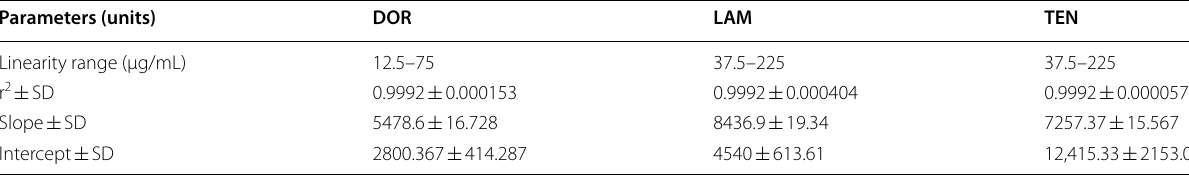
Table 3 Linear regression data of DOR, LAM and TDF